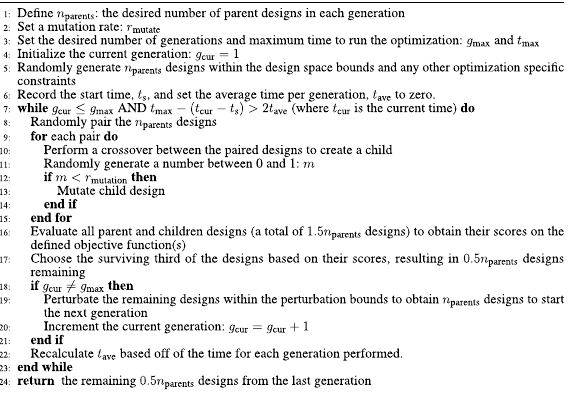
Algorithm 5. Evolutionary Algorithm Implementation